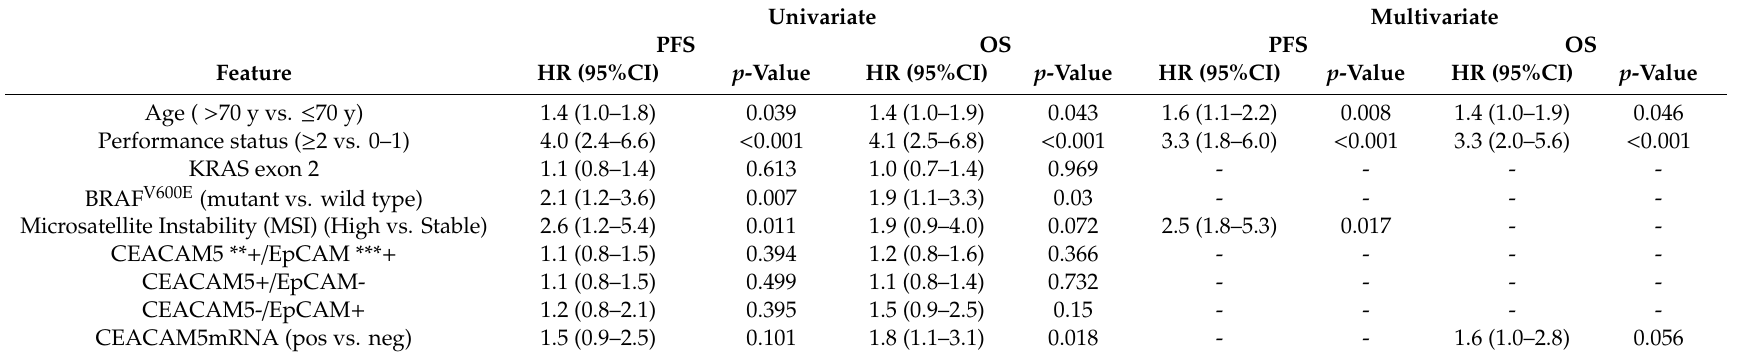
Table 3. Univariate and multivariate analysis for progression-free survival (PFS) and overall survival